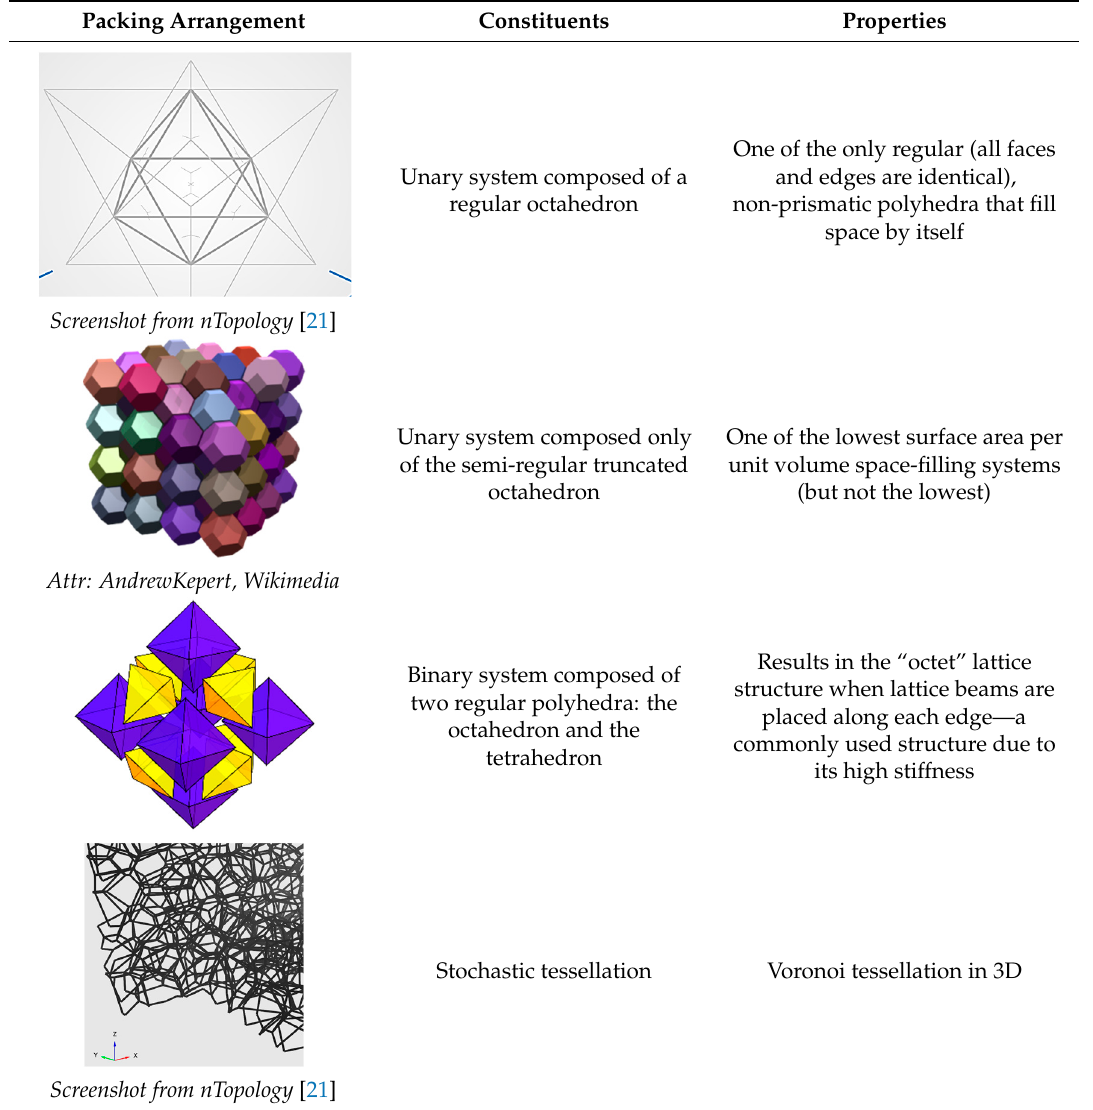
Table 2. Examples of 3D space-filling with non-prismatic polyhedra.